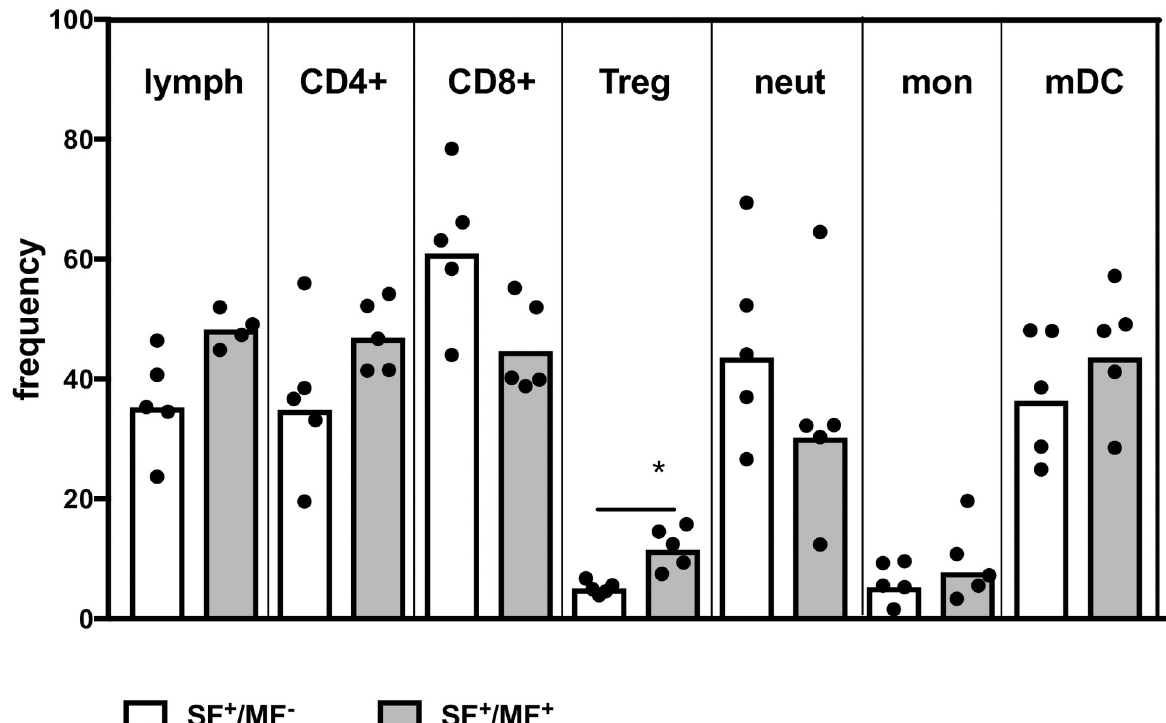
Fig 5. SF + /MF + individuals have a higher frequency of Treg than SF + /MF - individuals. Whole blood from SF + /MF + (n = 5) and SF + /MF - (n = 5) individuals were RBC-lysed and frequency of different subsets were measured by flow cytometry. Frequency of B lymphocytes were not different between SF + /MF - and SF + /MF + (1.81 ± 1.21 and 3.96 ± 2.38 respectively, p = 0.11). Statistical difference in frequency of subsets between the two groups are measured using nonparametric Mann- Whitney; � ( p <